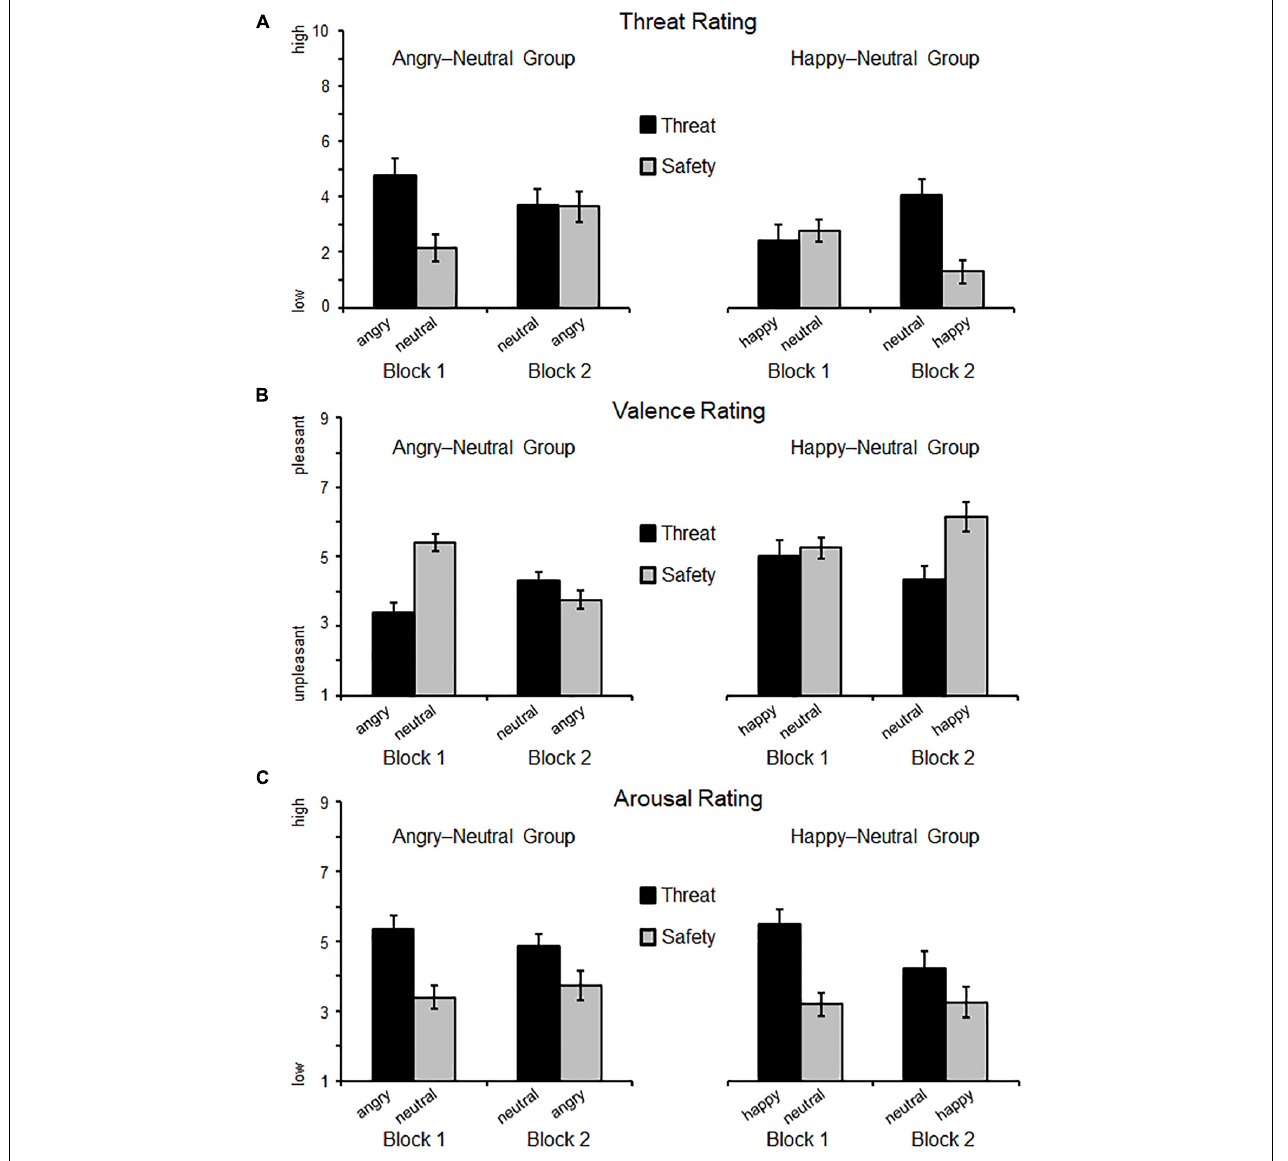
FIGURE 2 | Self-reported threat (A) , valence (B) , and arousal (C) ratings as a function of Block (first, second) and Instruction (threat, safety). Means (SEM) are plotted separately for each group: on the left side, the Angry–Neutral Group started with angry expression as threat cue, and on the right the Happy–Neutral Group with happy faces cueing threat in the first block. For both groups neutral faces served as reversed threat cue in the second block.